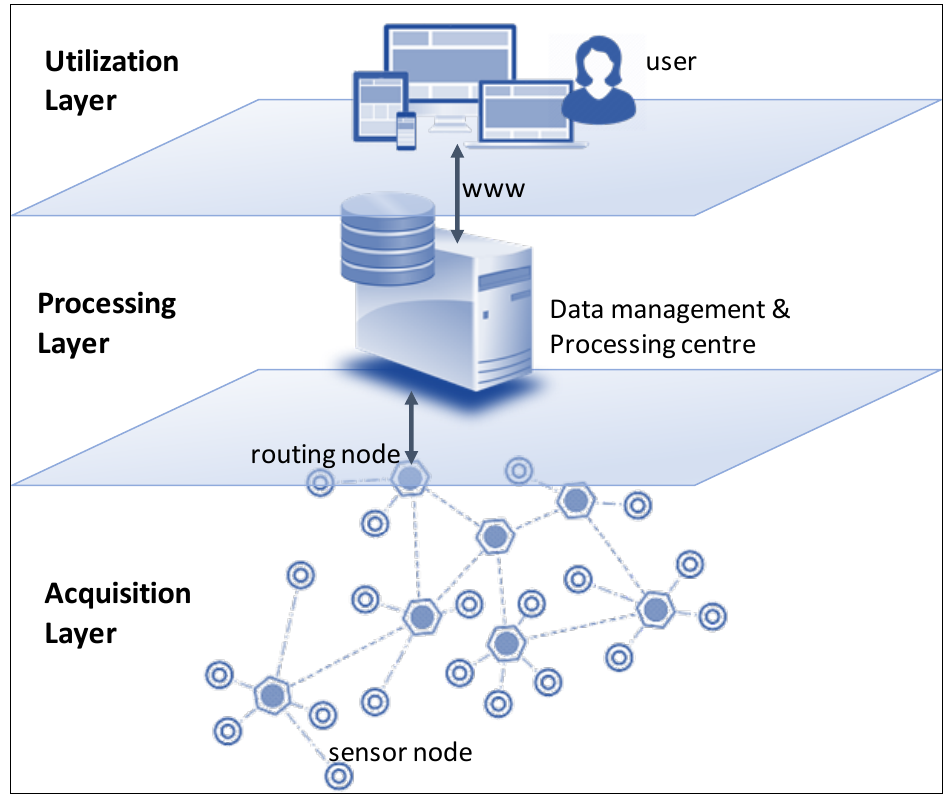
Figure 1. Layers in SCP environments.